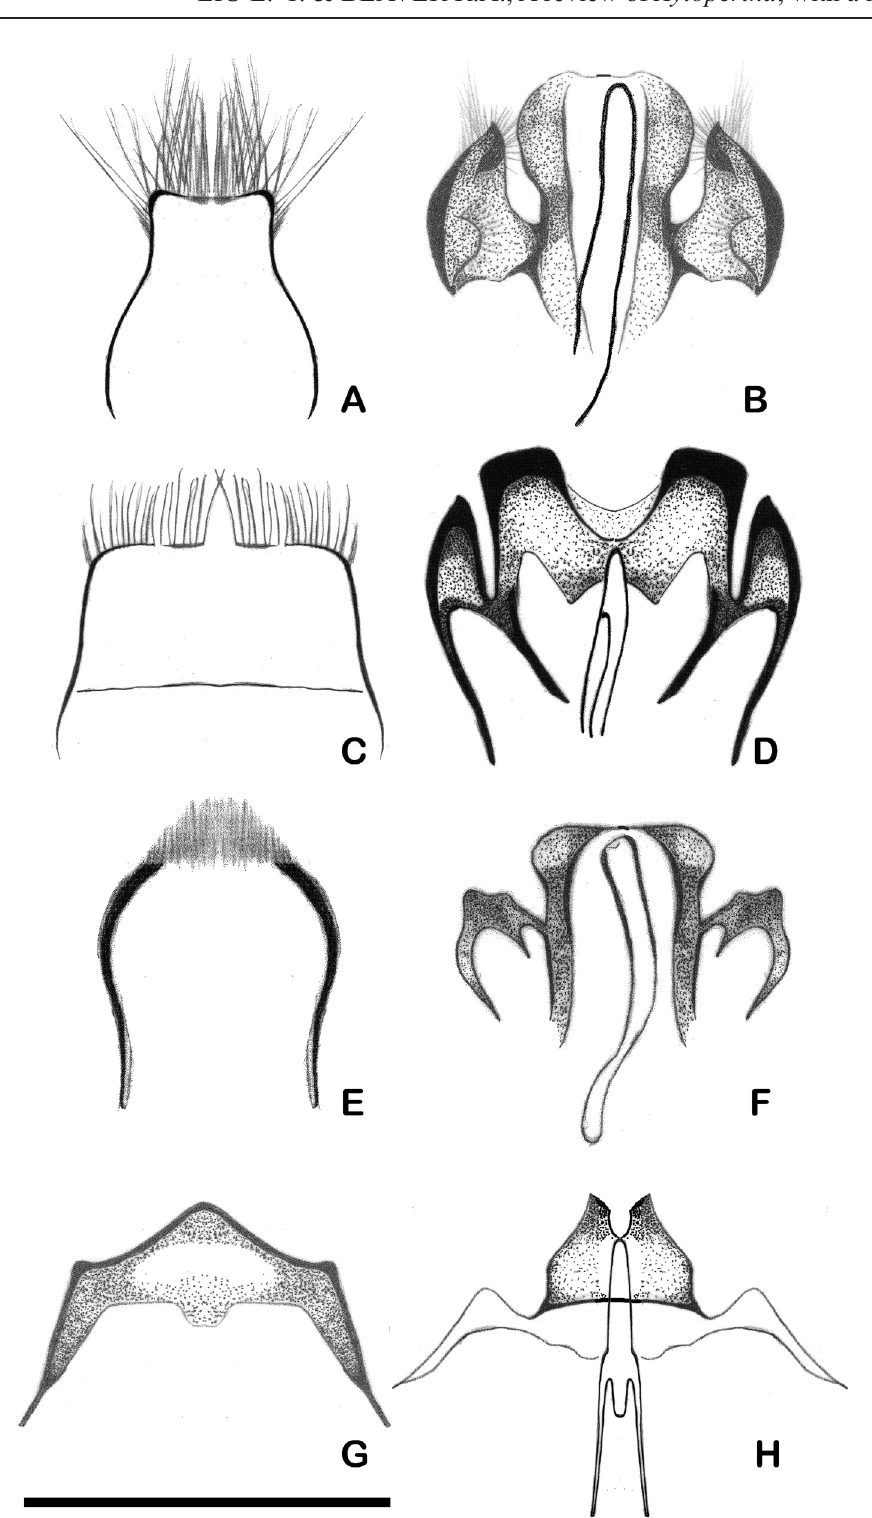
Fig. 5. Male 8 th tergite, 5 th ventrite and aedeagus of species of Xylopertha Guérin-Méneville, 1845. A . Xylopertha retusa (Olivier, 1790), 8 th tergite. B . X. retusa (Olivier, 1790), 5 th ventrite and aedeagus. C . X. praeusta (Germar, 1817), 8 th tergite. D . X. praeusta (Germar, 1817), 5 th ventrite and aedeagus. E . X. elegans sp. nov., 8 th tergite. Figure F . X. elegans sp. nov., 5 th ventrite and aedeagus. G . X. reflexicauda (Lesne, 1937), 8 th tergite. H . X. reflexicauda (Lesne, 1937), 5 th ventrite and aedeagus. Scale bar = 1